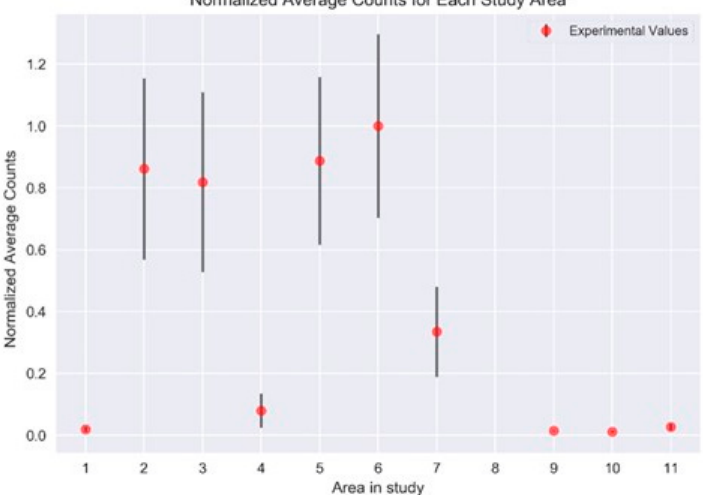
Figure 8. Average number of counts normalized to the maximum value for each sample, and the associated error bars.